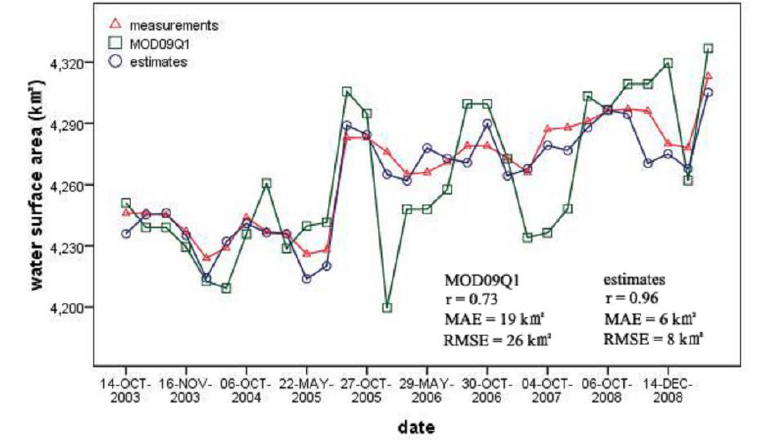
Figure 5. Time series of surface areas extracted from MOD09Q1 and surface areas estimated